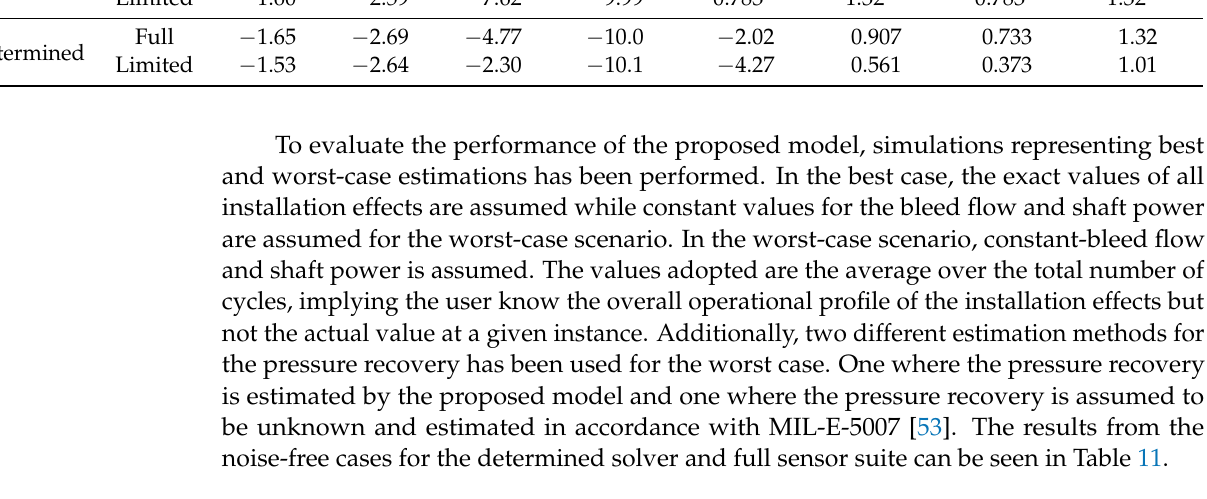
Table 11. Actual and estimated degradation patterns, without measurement noise for various installation effect estimation methods. * Efficiency equal hurt assumed. + Pressure recovery according to proposed model. ++ Pressure recovery according to